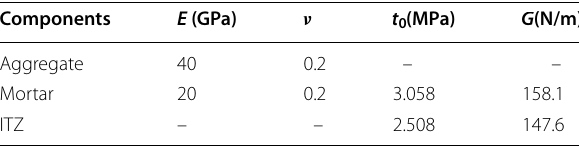
Table 4 Material parameters